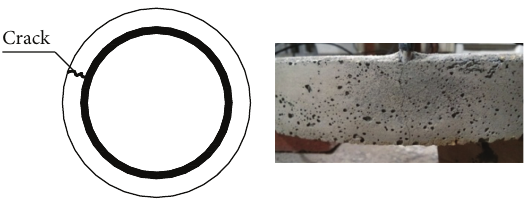
Figure 2: Cracking of the restraint ring.